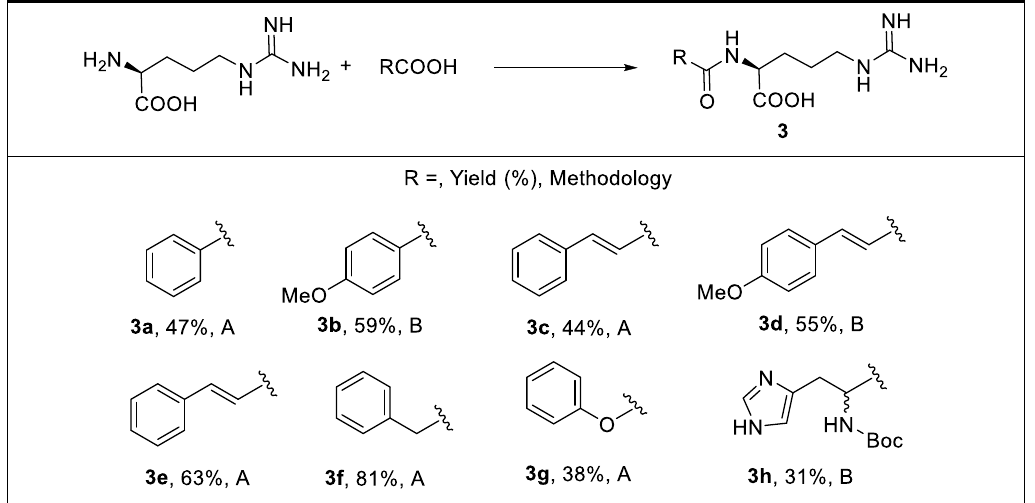
Table 1. Procedures used via acyl chloride (Method A) or coupling reagent (Method B) for the preparation of N α - L -arginine acyl derivatives ( 3 ).